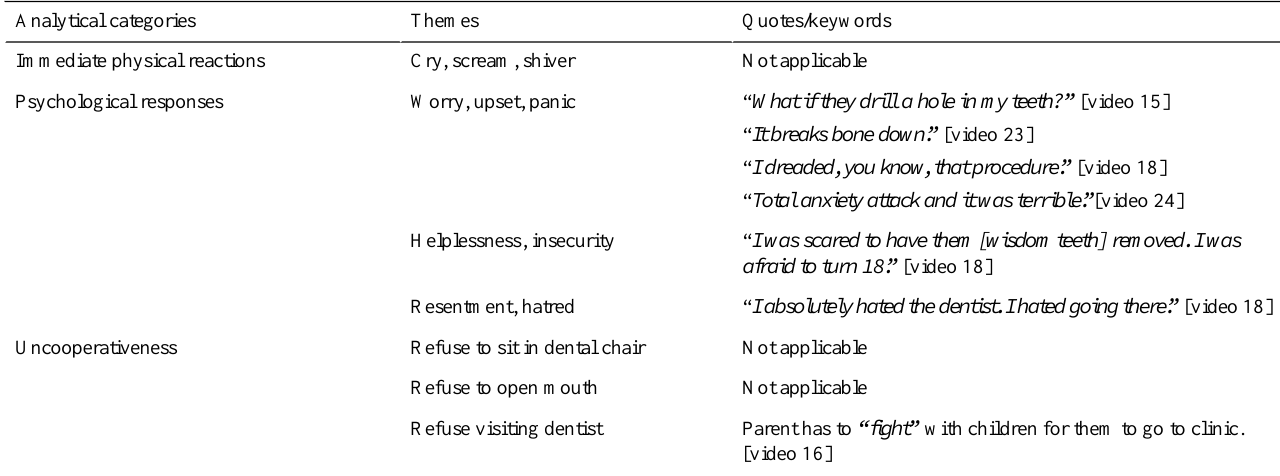
Table 2. Manifestations and impacts of DFA on children and